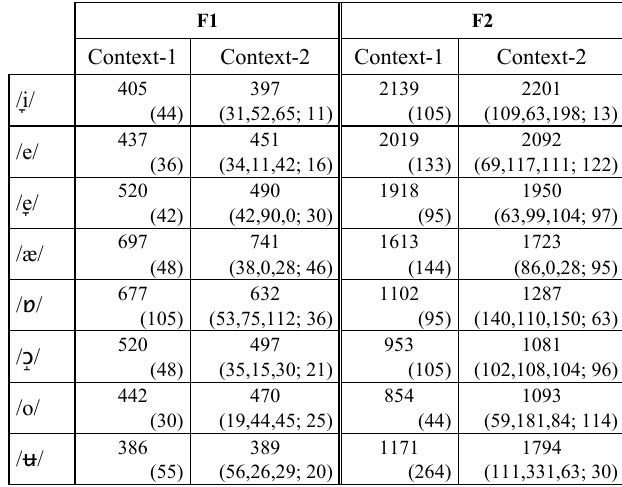
Table III and figure 1 systematize the respective data. Table III. Praia da Salema contextual vowel values (Hz, mean values; standard deviations in